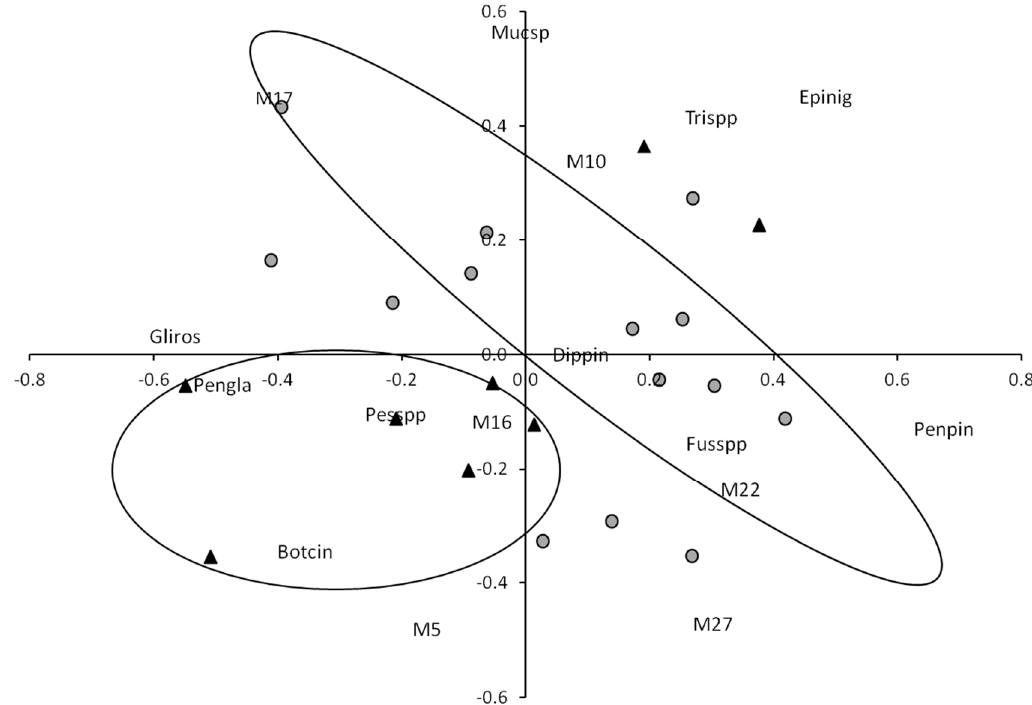
Figure 2. Multivariate analysis for fitting seasonal variables to NMDS ordination plots. Fungal species (Mucsp = Mucor sp., Epinig = E. nigrum , Trispp = Trichoderma spp., Gliros = G. roseum , Dippin = D. sapinea , Pengla = P. glabrum , Pesspp = Pestalotiopsis spp., Fusspp = Fusarium spp., Penpin = P. pini , Botcin = B. cinerea ) correspond to those isolated from the galleries in the shoots. Symbols represent the sites ( = plots sampled during autumn, = plots sampled during summer).